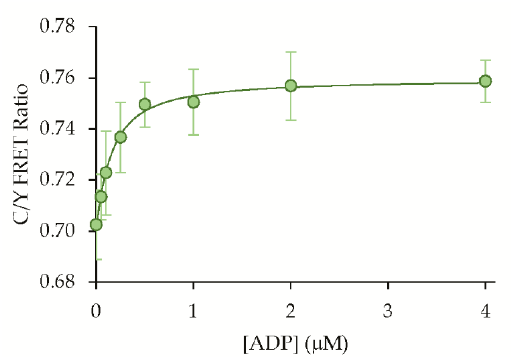
Figure 5. ADP affinity. The ADP dose response of the sensor was measured using purified protein in solution with an apparent K d = 0.16 ± 0.06 µM (mean ± std, n = 9).